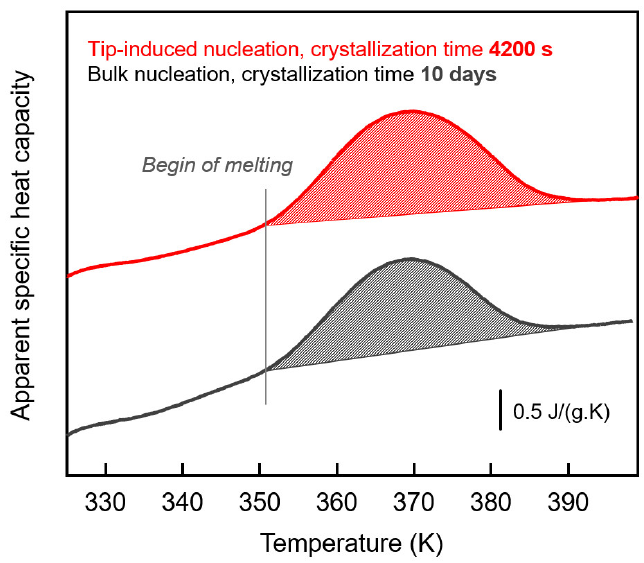
Figure 5. FSC heating scans of PCL, crystallized at 330 K, initiated by AFM-tip-induced surface- nucleation (crystallization time 4200 s) (red, top curve), and by bulk nucleation (crystallization time 10 days) (black, bottom curve). Note that the melting event apparently is observed at a temperature higher than T m,0 , because of instrumental thermal lag at fast heating.